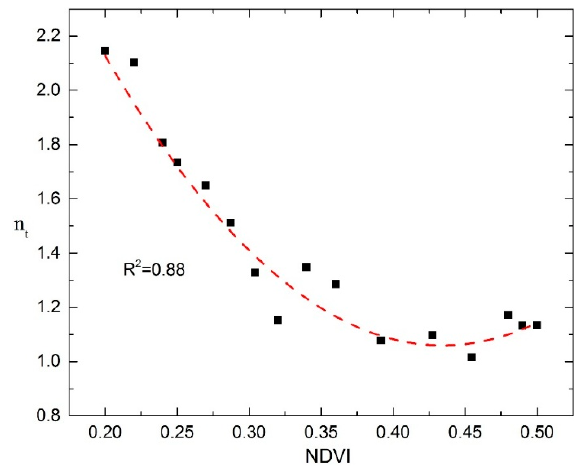
Figure 2. Summer mean n t factor vs. Normalized Differential Vegetation Index (NDVI) based on in situ measurements (2012–2016) [25]. The red line represents the fit following Equation (2).